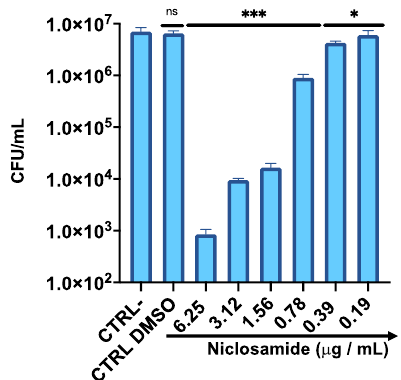
Figure 6. Intracellular survival of C. striatum in the HaCaT cell line after treatment with niclosamide. CTRL-: untreated cells; CTRL DMSO: cells treated with the solvent used to dissolve the drug.